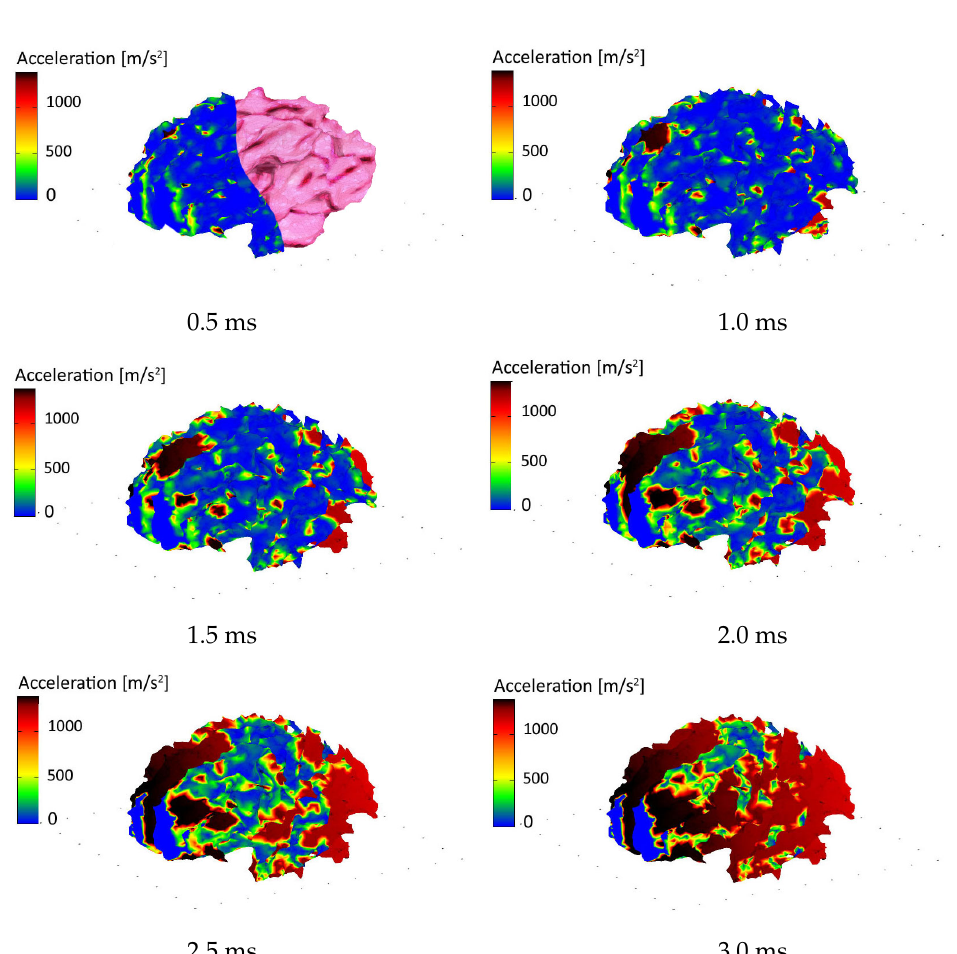
Figure 9. Simulated accelerations in the brain at six successive stages of head